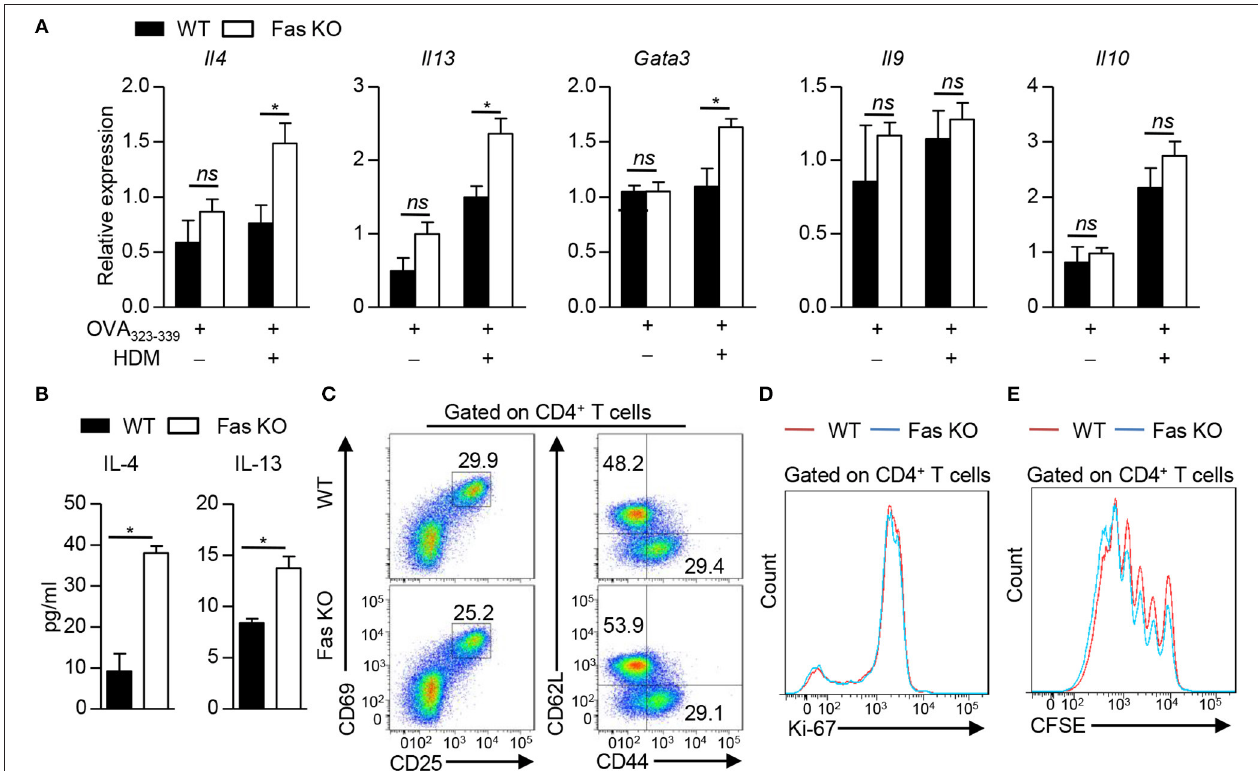
FIGURE 4 | Fas signaling in BMDCs instructs Th2 cell differentiation in vitro. (A–D) Co-culture of wild-type and Fas-deficient BMDCs with naïve OT-II CD4 + T cells (CD4 + CD25 − CD62L + CD44 − ) in the presence of OVA 323 − 339 with or without HDM for 48h (A) , 3 days (B,D), 18h (C) , and then CD4 + T cells were harvested for analyses. (A) mRNA expression of Il4 , Il13 , Gata3 , Il9, and Il10 was detected by qPCR and normalized to Hprt . (B) Production of IL-4 and IL-13 was detected by ELISA. (C) Flow cytometry of the activation status of OT-II CD4 + T cells. (D) Flow cytometry of Ki-67 expression in OT-II CD4 + T cells. (E) Naïve OT-II CD4 + T cells were labeled with CFSE and then co-cultured with wild-type or Fas-deficient BMDCs in the presence of OVA 323 − 339 and HDM for 4 days. Flow cytometry of CD4 + T cell proliferation. * P < 0.05, ns , not significant. Data are representative of two independent experiments with duplicate or triplicate wells per group (A , B) . Student’s t -tests were performed and data were presented as mean ±